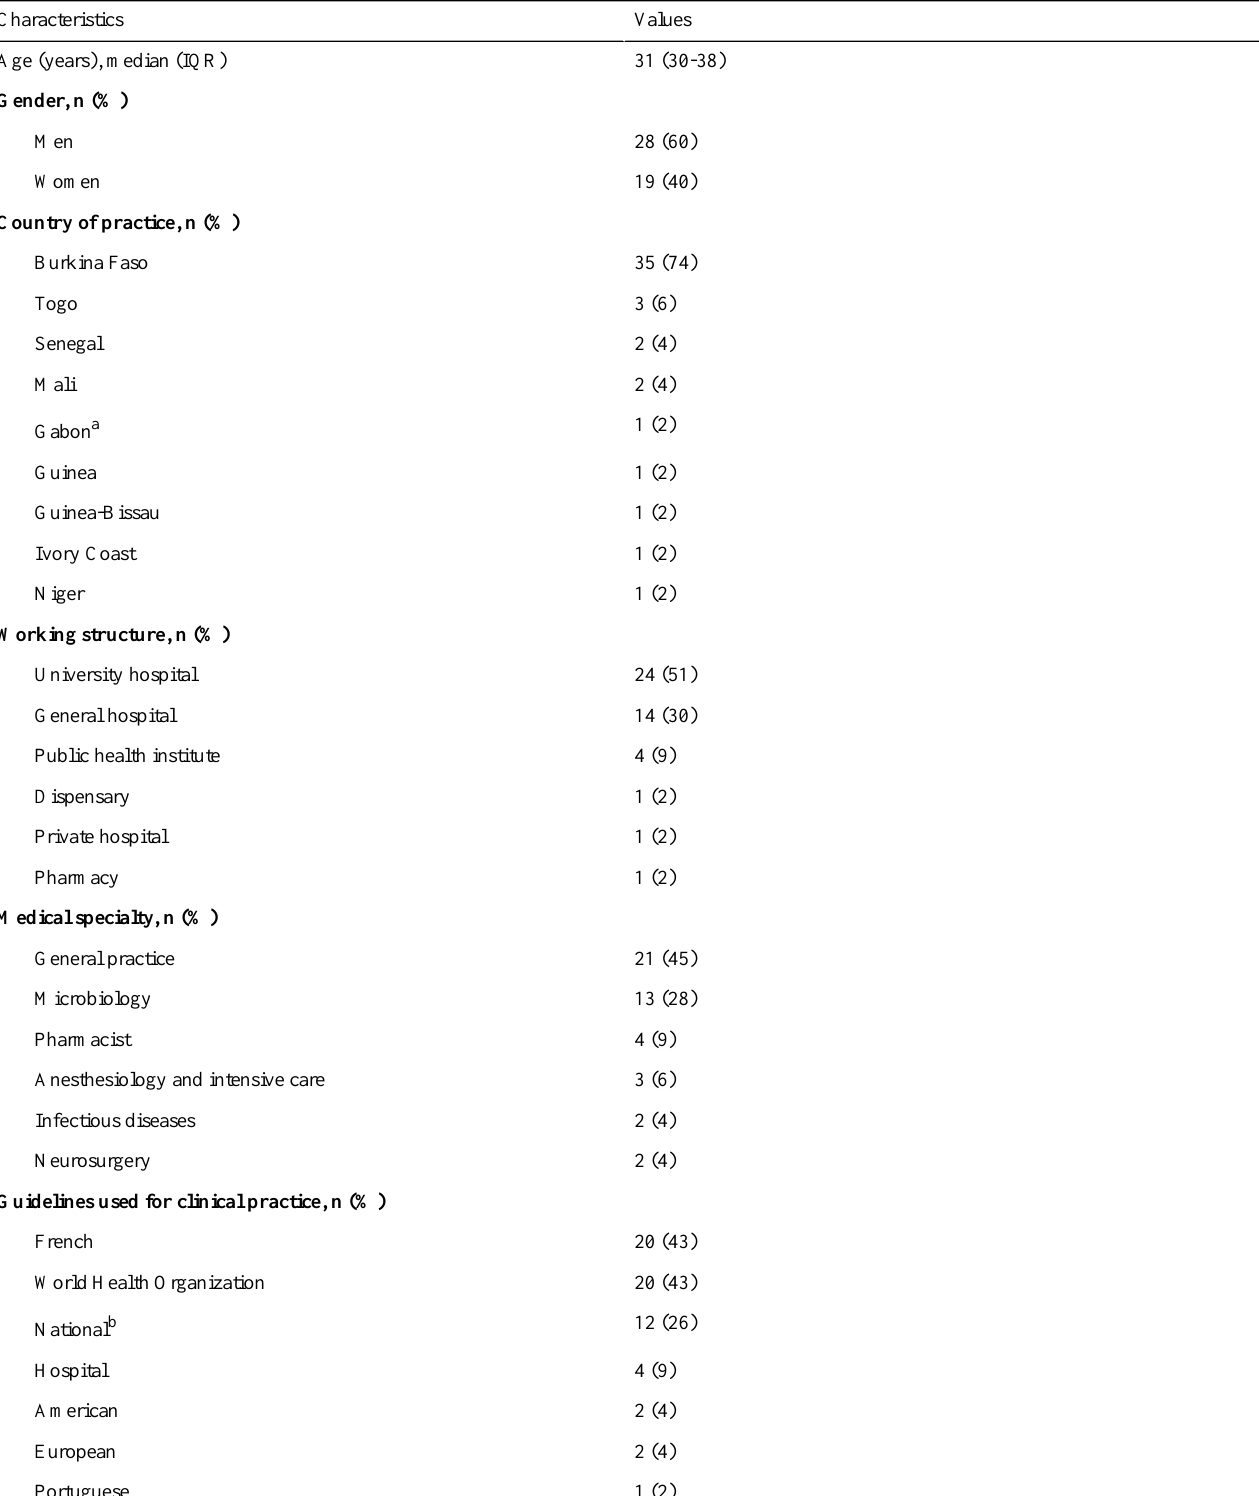
Table 1. Demographic characteristics of participants (N=47).